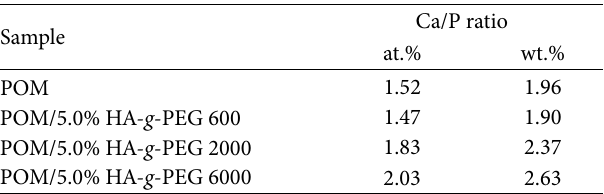
Figure 13: pH and conductivity changes of PBS and RF solutions as a function of incubation time of pristine POM and POM/HA- g -PEG 600 Table 5: EDX chemical ratio of Ca/P of apatite on the surface of POM/HA- g -PEG composites.